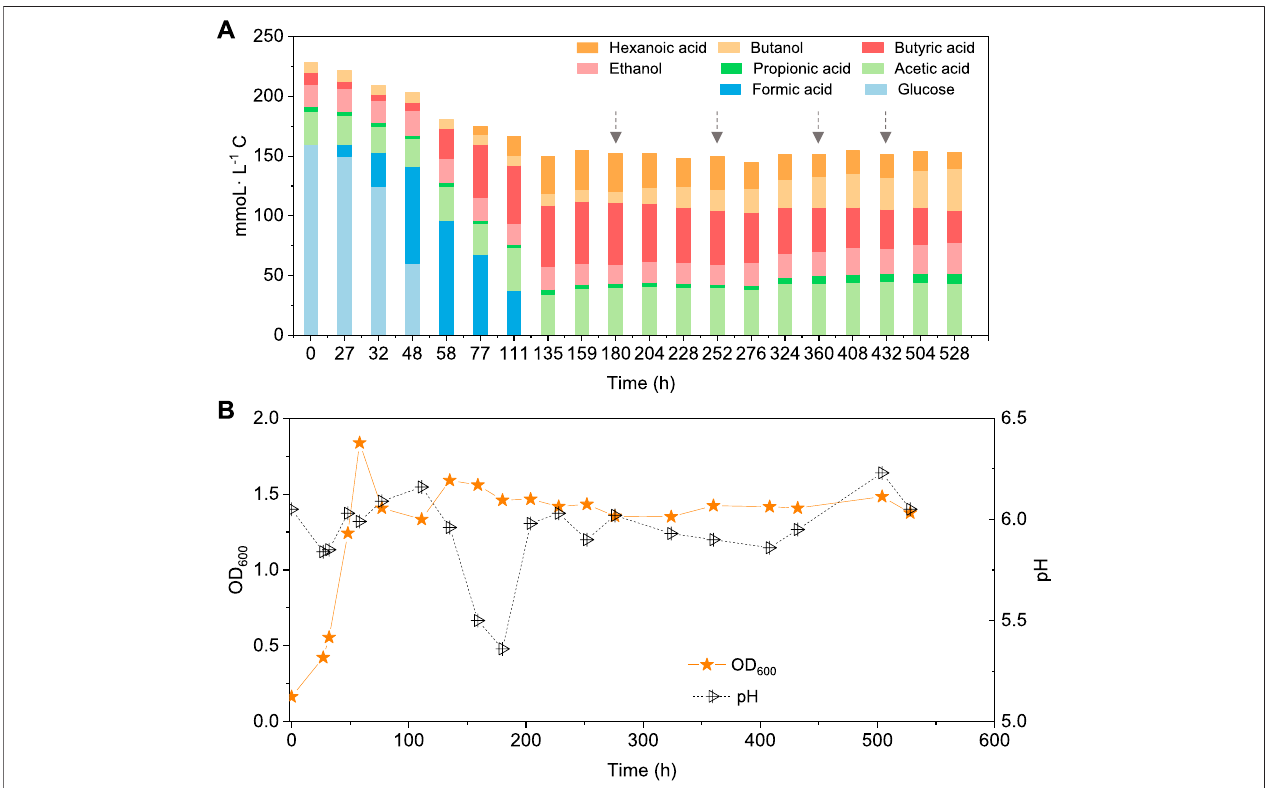
FIGURE 5 | (A) Production of acids and alcohols and (B) cell concentration and pH by enriched sludge using 5 g/L glucose as the substrate in a gas fed reactor (Glucose + N 2 ). The arrows represent 1.1 bar CO addition at 180, 252, 360 and 432 h. pH was controlled at 5.5 –